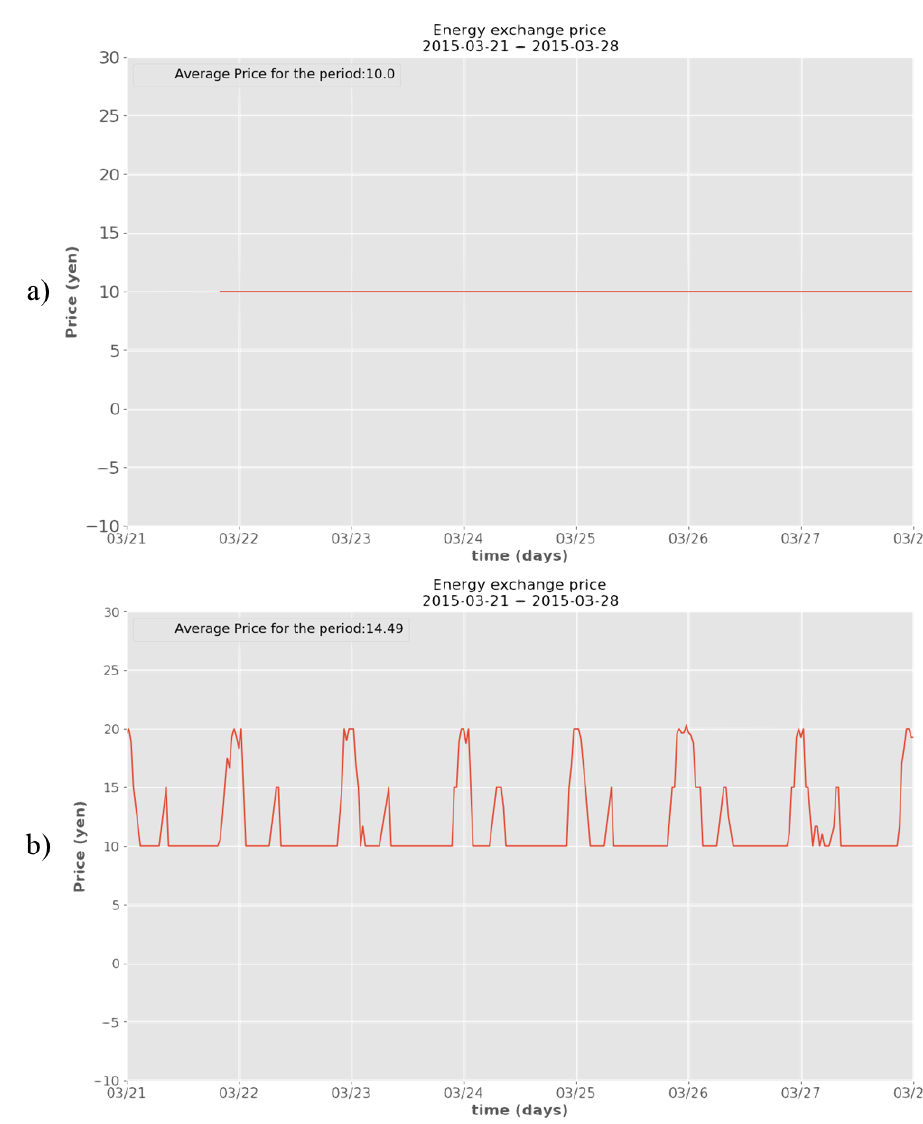
Figure 10. Market price within a community, comprised of standalone houses with solar panels and fuel cells, using priority-based internal agent ( a ) without fuel cell scheduling function and ( b ) with added scheduling